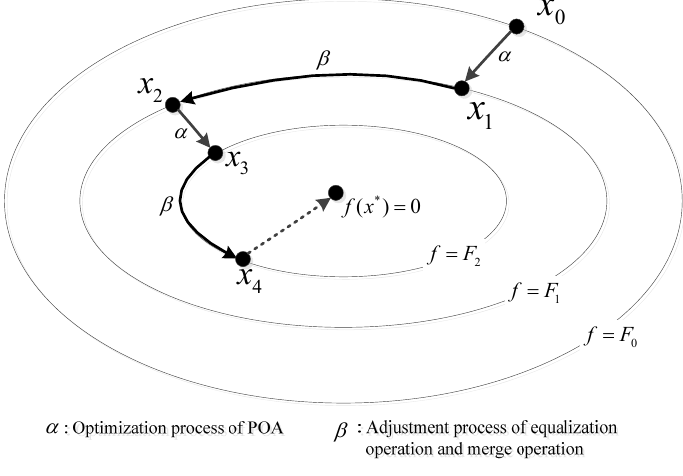
Figure 5. Sketch map of the search principle.